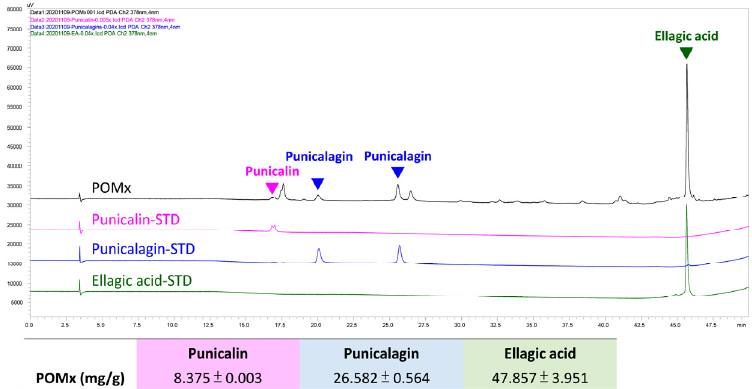
Figure 1. HPLC profile of POMx and the contents of its three main bioactive components. The HPLC profile for punicalagin, ellagic acid, and punicalin was provided as well as their contents within POMx (mg/g). STD means